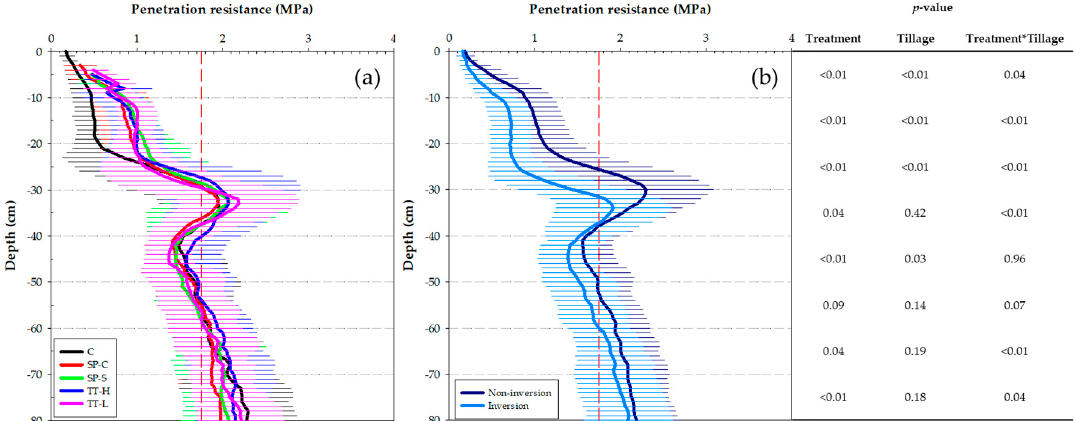
Figure 7. Average penetration resistance (MPa) ± standard deviation for the untreated control (C) and the four experimental treatments ( a ) ( n = 66) and for the tested tillage methods ( b ) ( n = 165) between 0 and 80 cm depth, adjusted for rut depth. The red dashed line represents the threshold values for sugar beet root growth (1.75 MPa).